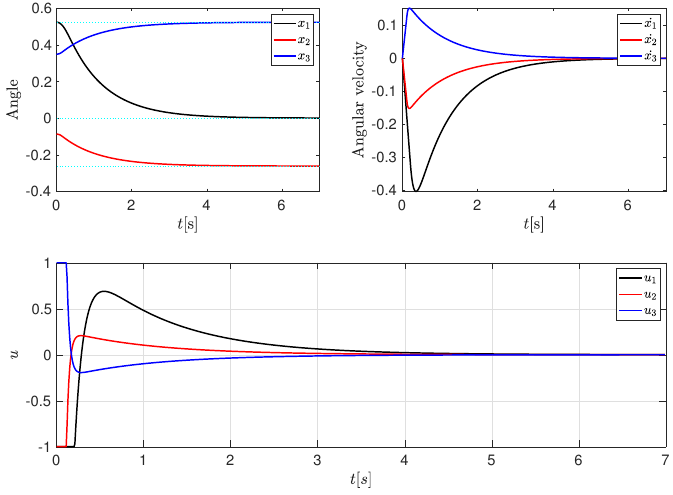
Figure 6. Angle, angular velocity, and input of the bipedal